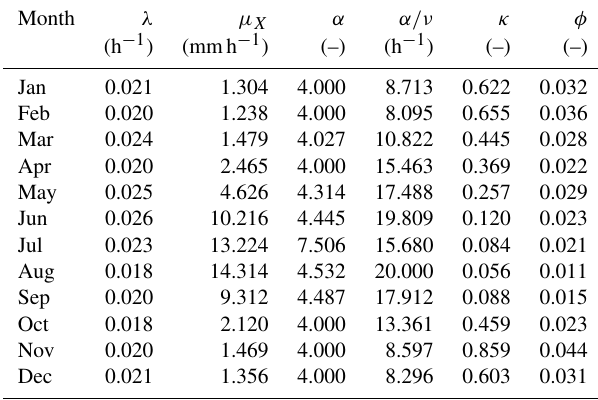
Table 2. Parameters for the RBL1-sM model using Bochum gauge data; constraint: α >